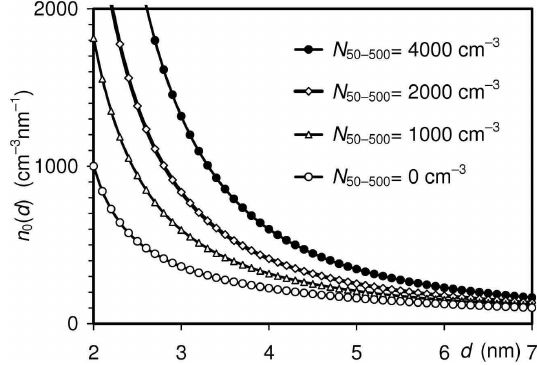
Fig. 4. Size distributions of neutral nanoparticles n 0 ( d ) in case of the near-median distribution of intermediate ions in Tartu (Fig. 1) calculated according to Eqs. (8) and (9) at constraints GR 0 (3 nm) = GR 0 (7 nm) = GR 1 and different trial values of the concentration of background aerosol particles N 50 − 500 . The growth rate was estimated to be 0nmh − 1 at N 50 − 500 =0cm − 3 , 1.15nmh − 1 at N 50 − 500 =1000cm − 3 , 2.03nmh − 1 at N 50 − 500 =2000cm − 3 , and 3.6nmh − 1 at N 50 − 500 =4000cm − 3 .